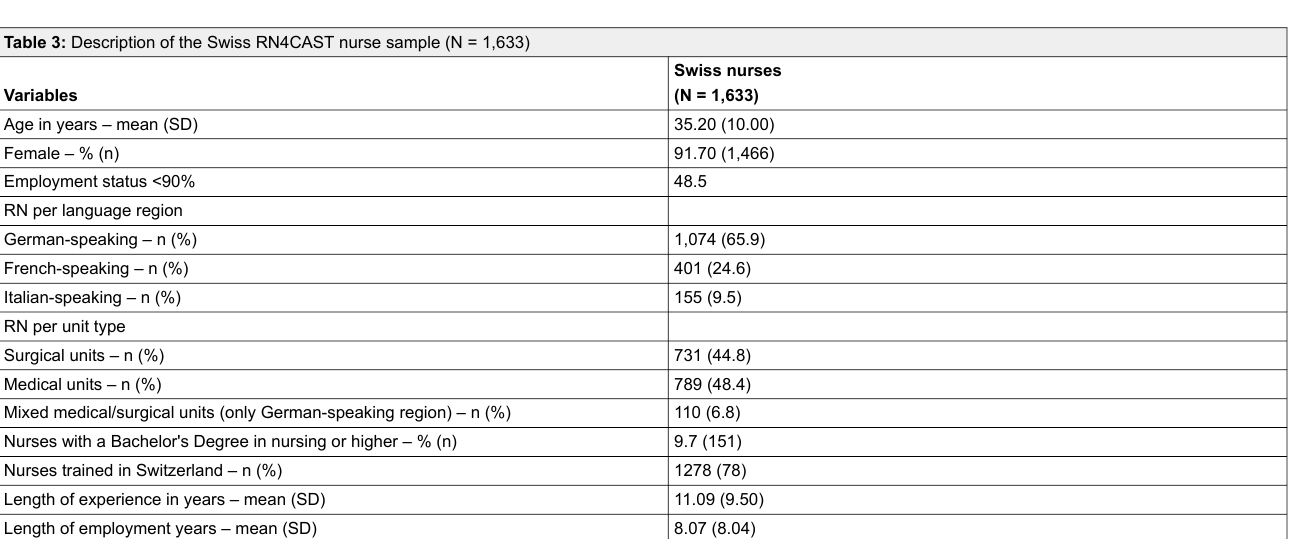
Table 3: Description of the Swiss RN4CAST nurse sample (N = 1,633)